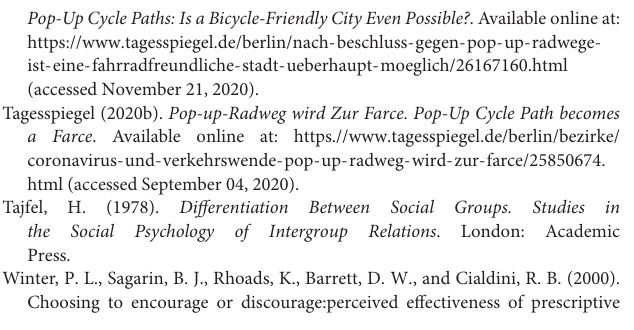
potential conflict of